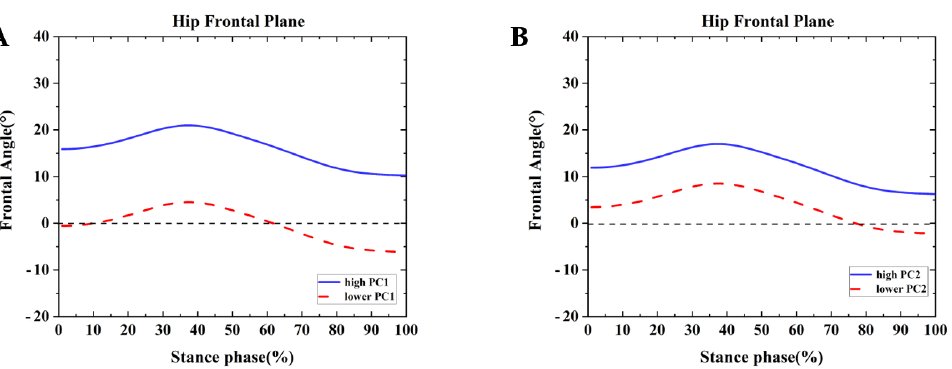
Figure 9. Principal components are retained for the hip. ( A ) The waveform differences between competitive runners and recreational runners of reconstruction principal using the high and lower PC1-scores in the frontal plane. ( B ) The waveform differences between competitive runners and recreational runners of reconstruction principal using the high and lower PC2-scores in the frontal plane.